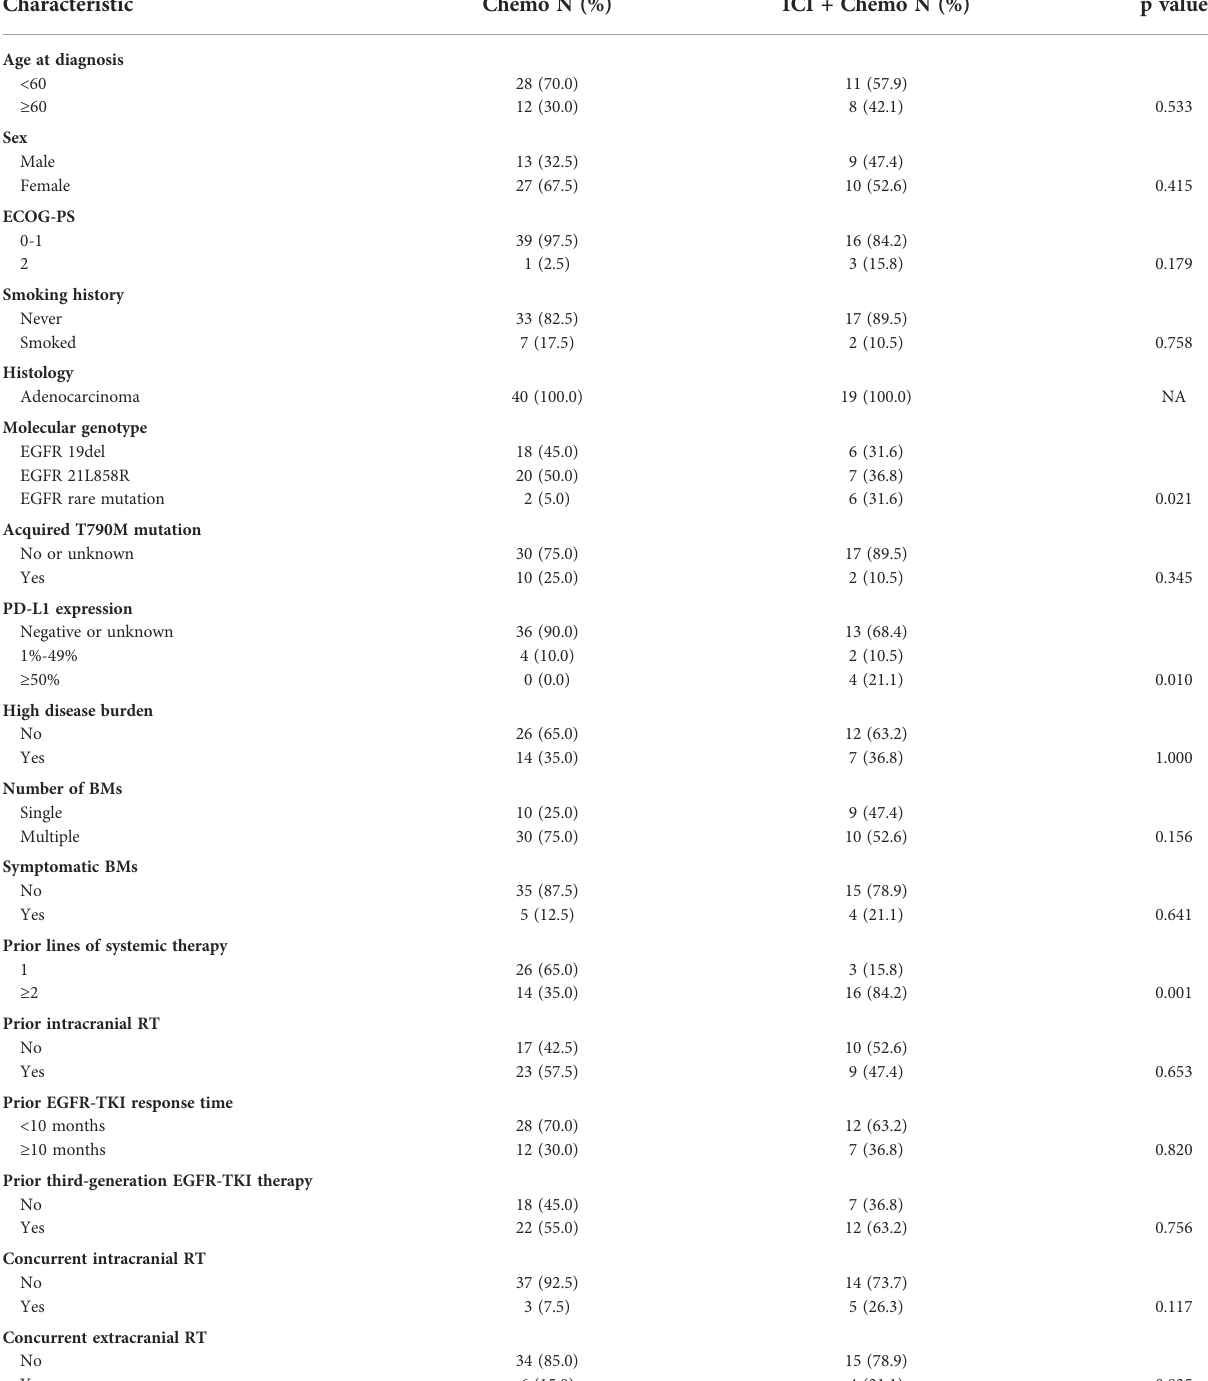
TABLE 3 Comparison of clinical characteristics between patients treated with chemotherapy alone and ICI plus chemotherapy.